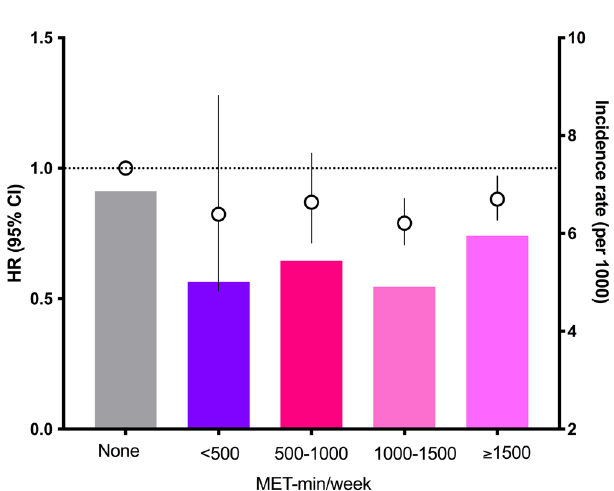
Figure 1. Incidence rates, hazard ratios, and 95% confidence intervals for cardiovascular disease in the new exerciser group according to energy expenditure (MET-min/week). The reference group was defined as the nonexerciser group. The analysis was adjusted for age, sex, body mass index, income status, hypertension, dyslipidemia, fasting blood glucose level, kidney function, use of insulin, number of oral hypoglycemic agents, alcohol intake, and smoking